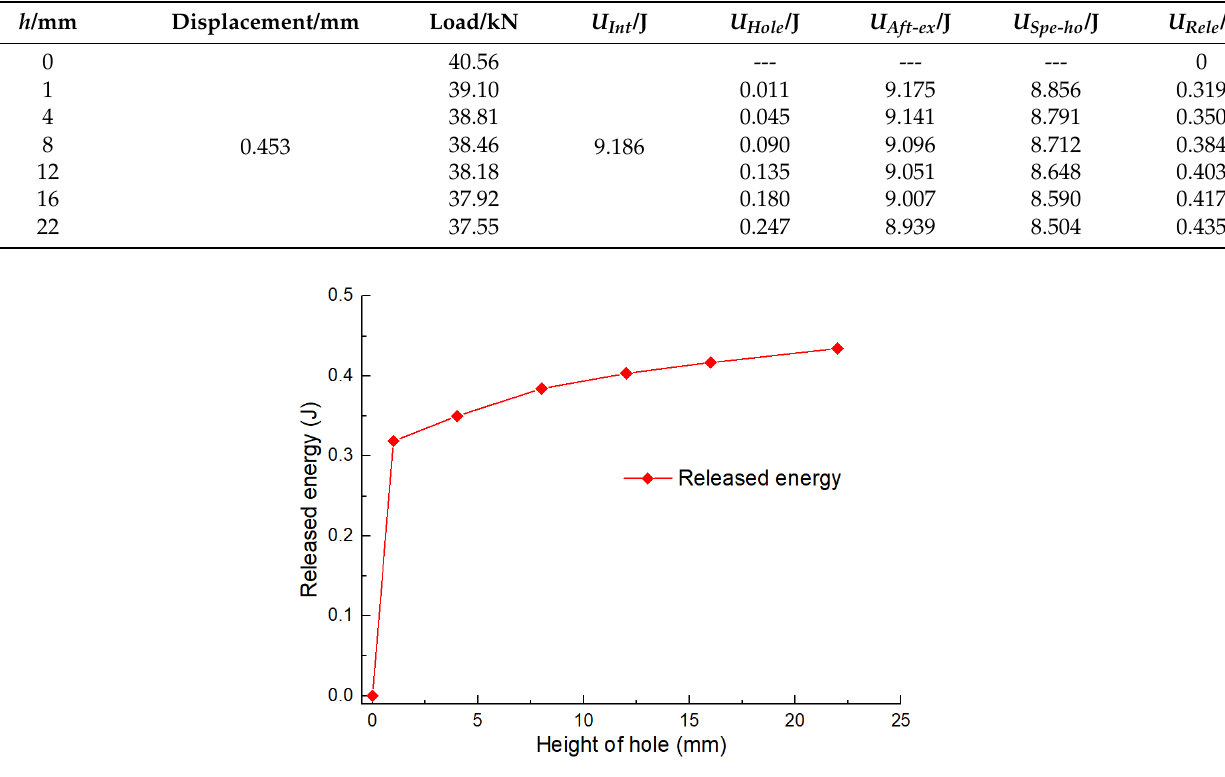
Table 6. The strain energy of each